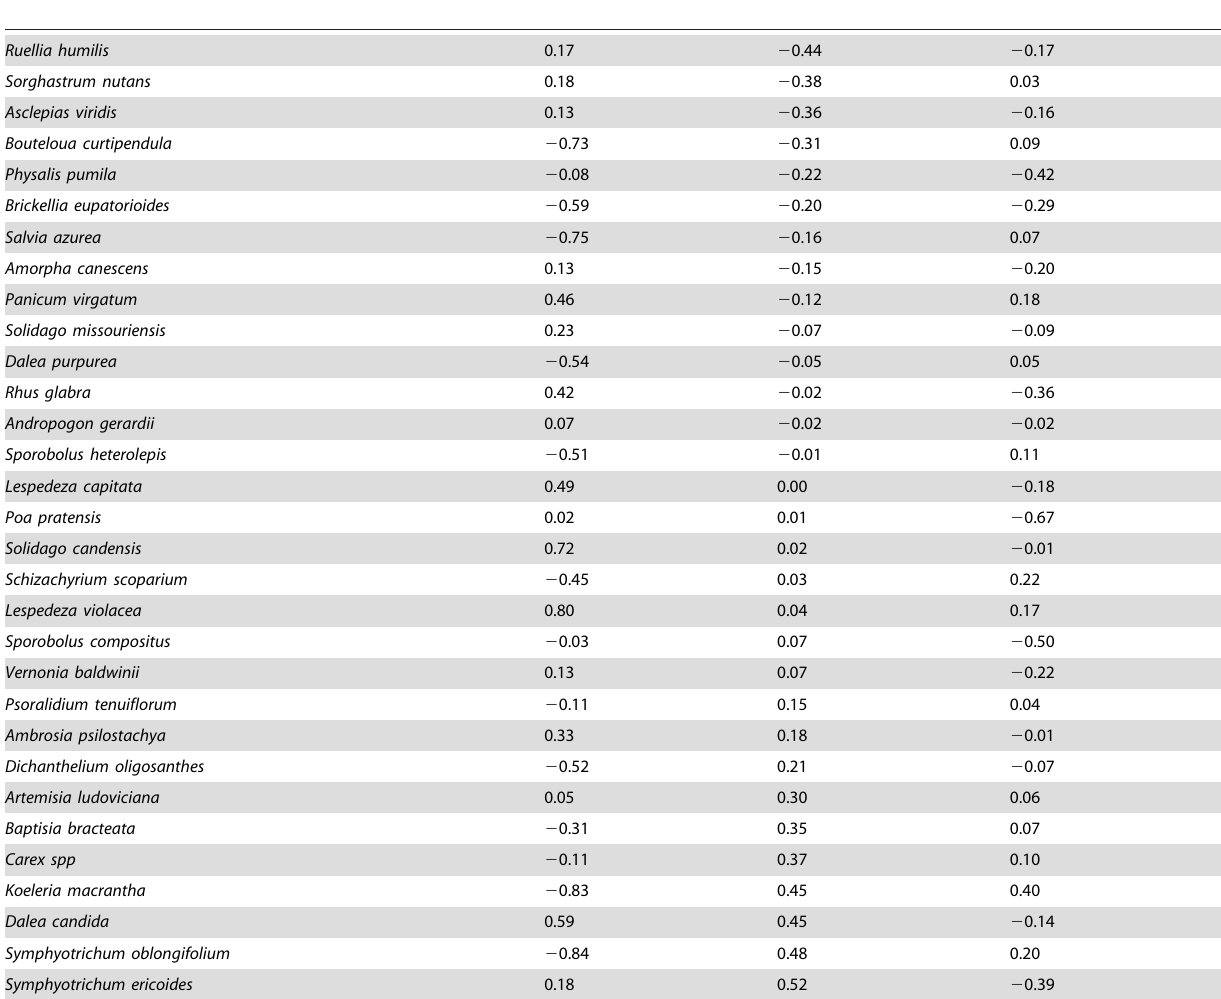
Table 1. Scores of species for the first three axes of non-metric multidimensional scaling analysis generated from the 31 most abundant species among the six watersheds of the